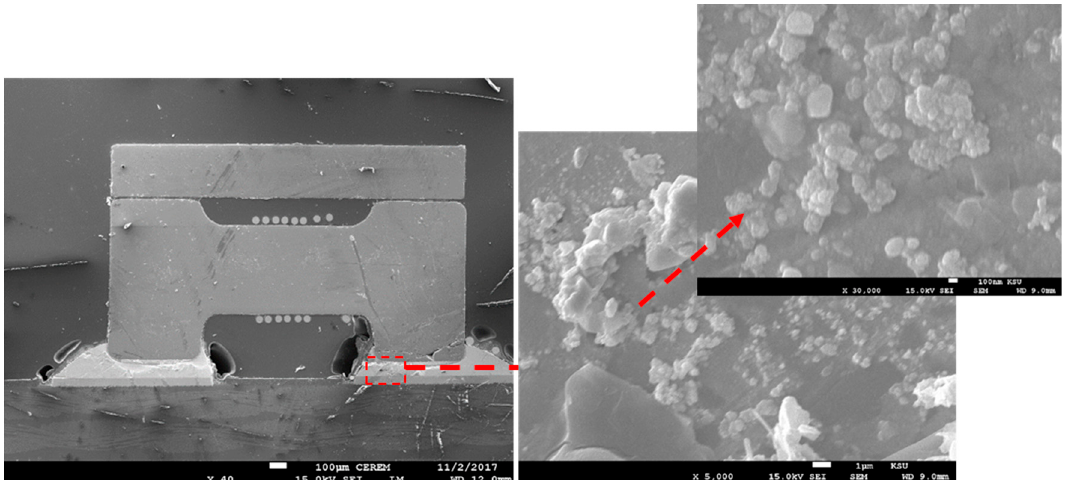
Figure 7. SEM micrograph for the joint interface of a passive component with SCAN-nano solder paste.